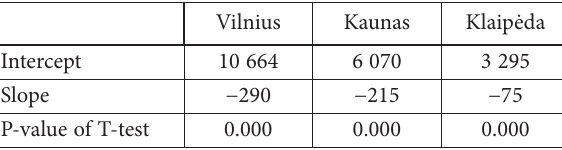
Table 5. Coefficients of a simple linear regression between the number of newcomers and unemployment rate Vilnius Kaunas